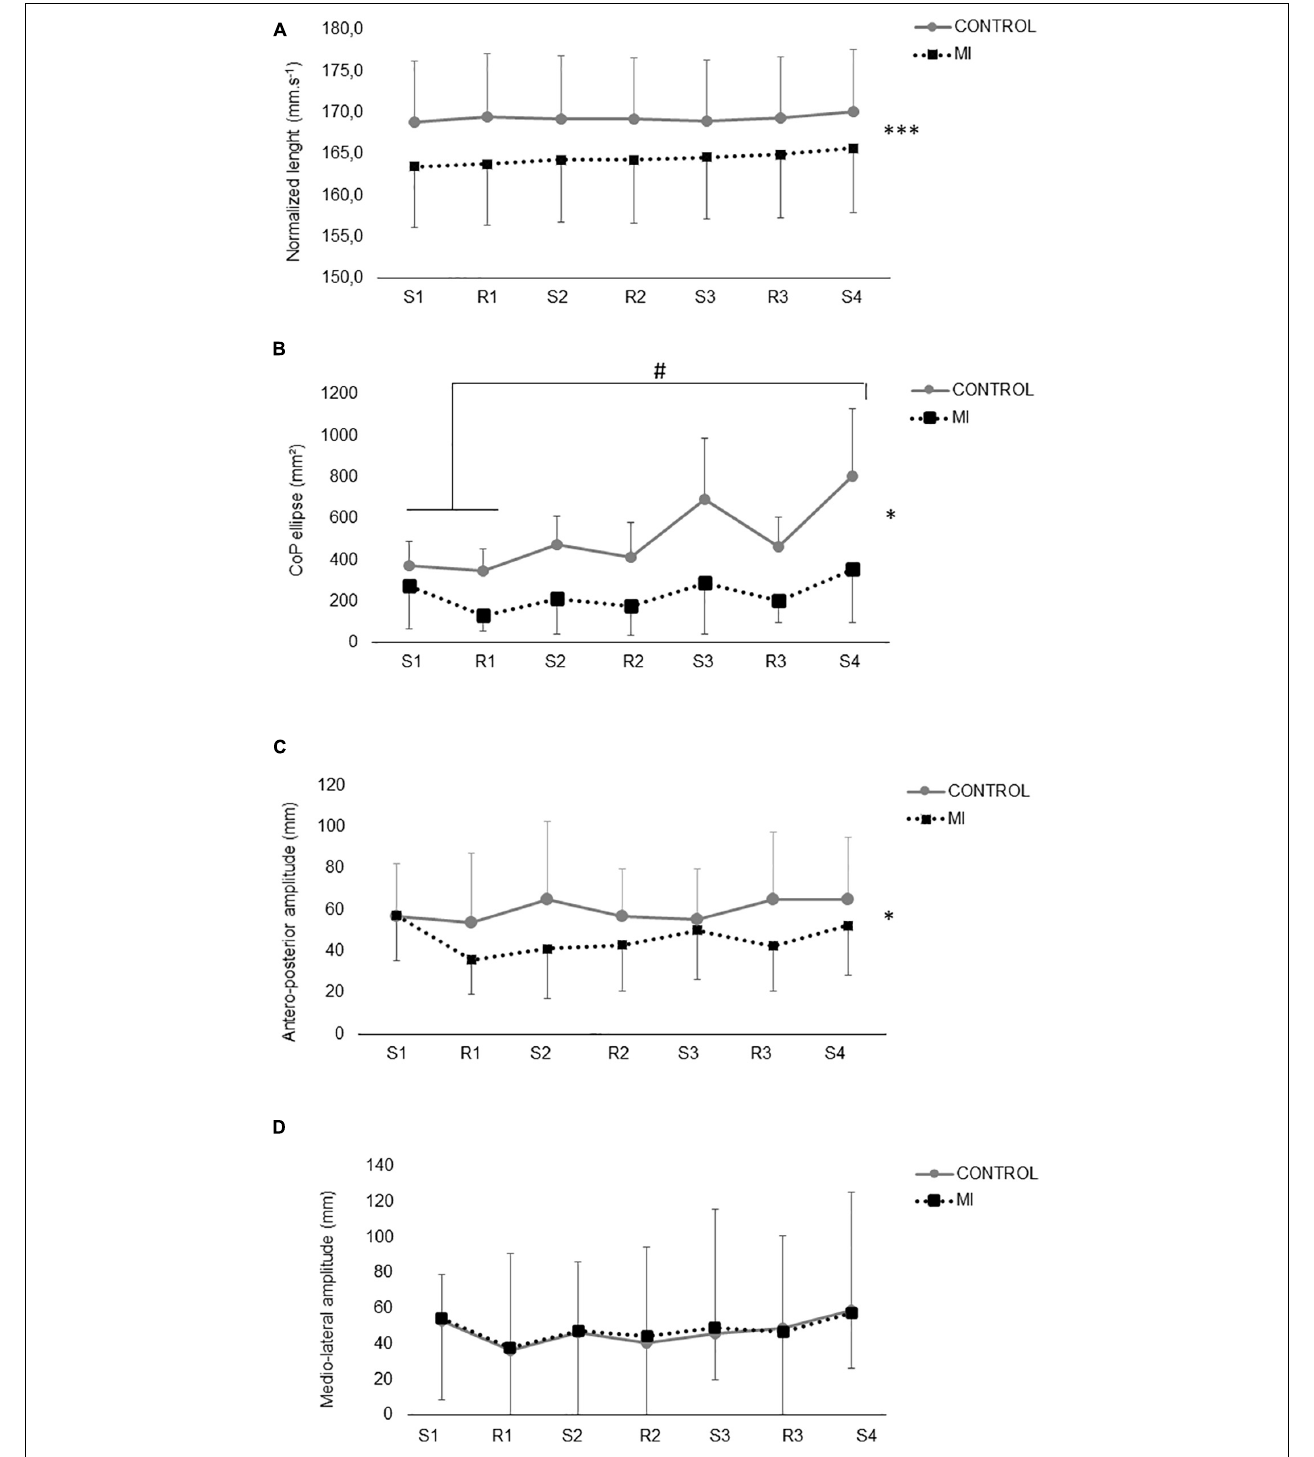
FIGURE 3 | Postural sway during motor imagery (MI) and control (CTRL) in standing condition. In panels (A–D) , data are split according to the different phases of the motor imagery session (MI, black squares): S1, S2, S3, and S4 are for the four different successive series of MI (2.5 min), while R1, R2, and R3 represent the three rest periods between the series (1.5 min). The same cut has been performed in the CTRL session to provide valuable comparison with MI session. In panel (A) , length of the Center of Pressure (CoP) is normalized by the duration of each period (in mm/sec). In panel (B) , CoP area (ellipse) is expressed in mm 2 in each phase. In panels (C,D) , the mean amplitude of the CoP displacement over the different time periods on the antero-posterior (C) and mediolateral (D) axis. ∗ and ∗∗∗ : main effect of the factor condition (MI vs. CTRL) at p < 0.05 and p < 0.001, respectively. #: significant differences between the indicated time points, at p < 0.05.